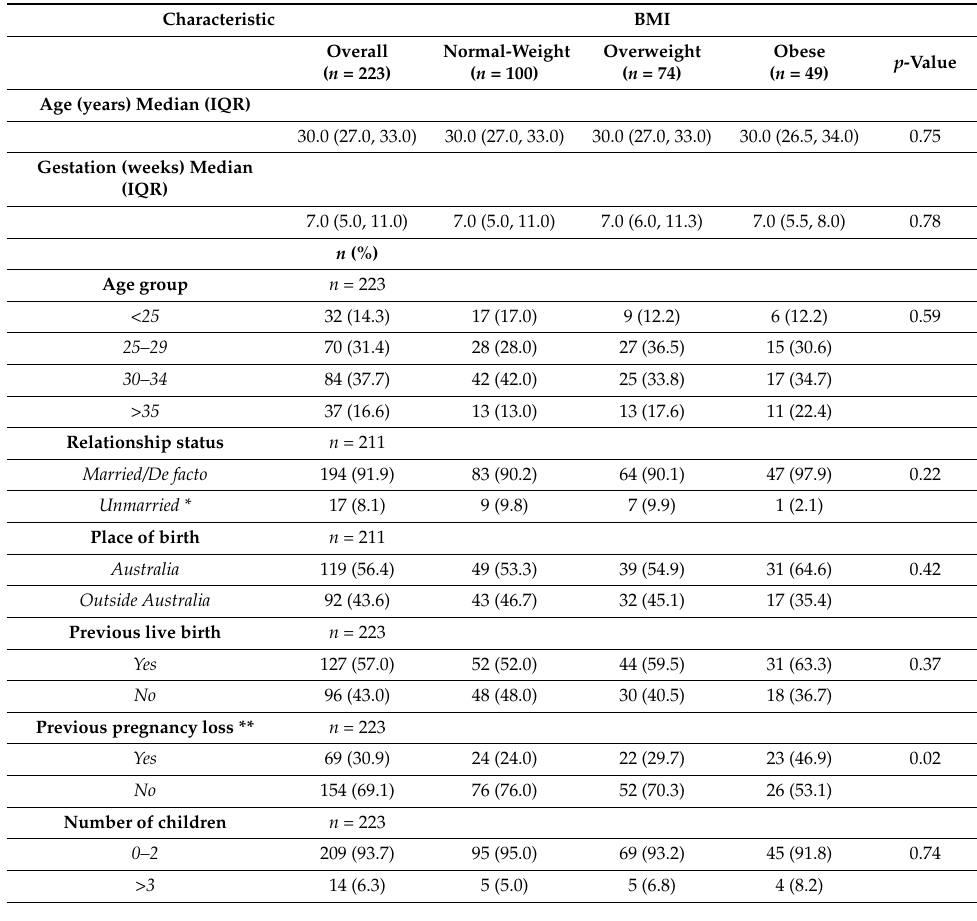
Table 1. Participant characteristics stratified by